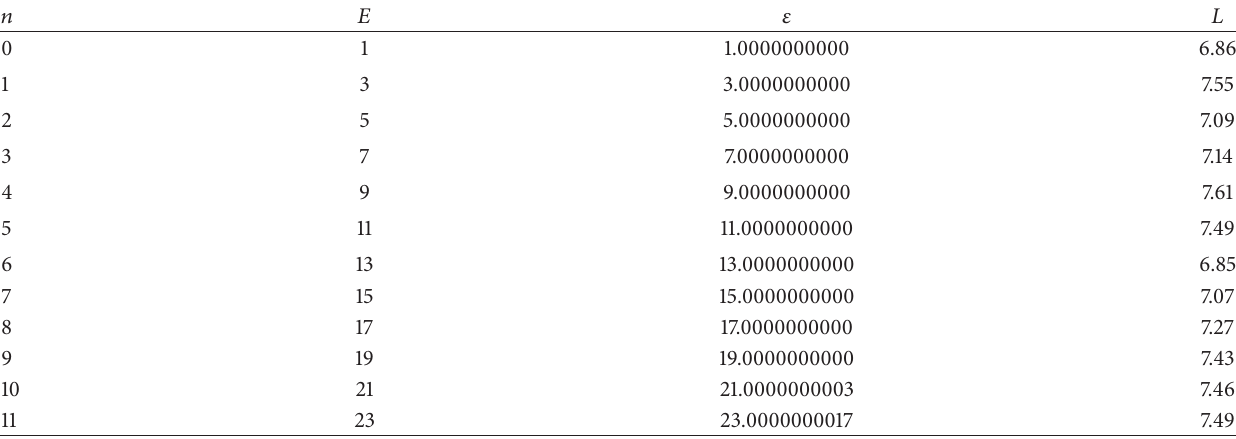
Table 1: Approximation of the energy levels of the harmonic oscillator 𝐻 = −Δ + 𝑥 2 in 𝑅 . Here, 𝑛 represents the energy state, 𝐸 is the exact solution for the energy, 𝜀 is the upper bound for 𝐸 obtained by the variational analysis, with the eigenvalues 𝜀 𝑛 of H minimized over the box size, and 𝐿 is the optimal value obtained. The table shows the energies of the first 12 states, 𝑛 = 0,1,...,11 . 𝑛 𝐸 𝜀 𝐿 0 1 1.0000000000